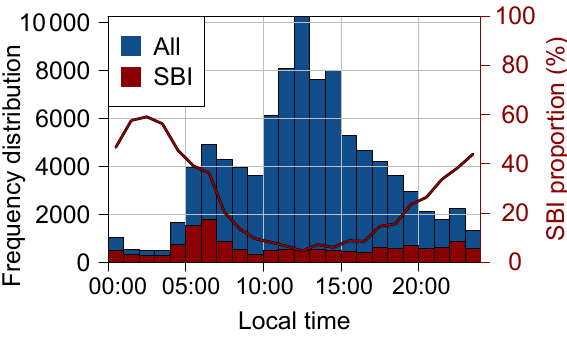
Figure 3. Frequency distribution of the measurement time of all vertical profiles (blue bars; left axis) and the profiles on which an SBI is detected (red bars superposed over blue ones; left axis). The corresponding proportion of SBI is also plotted (red line; right